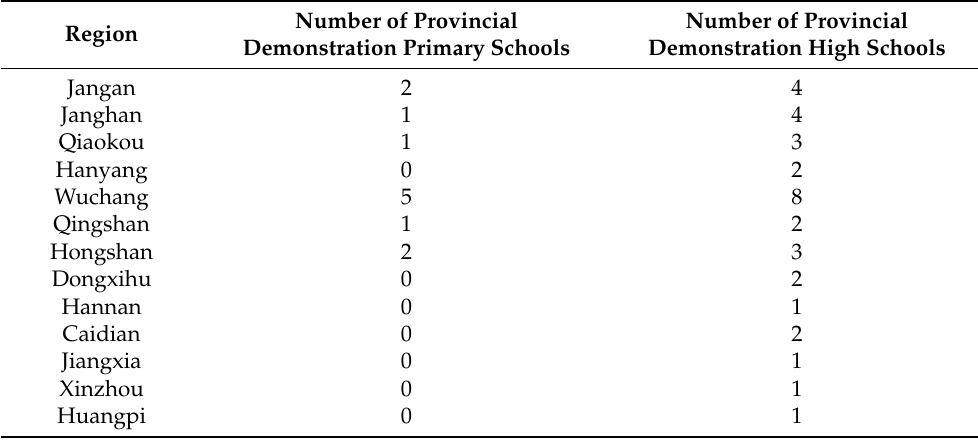
Figure 3. The distribution of sampling points in Wuhan. Table 1. Demonstrative list of schools in various regions of